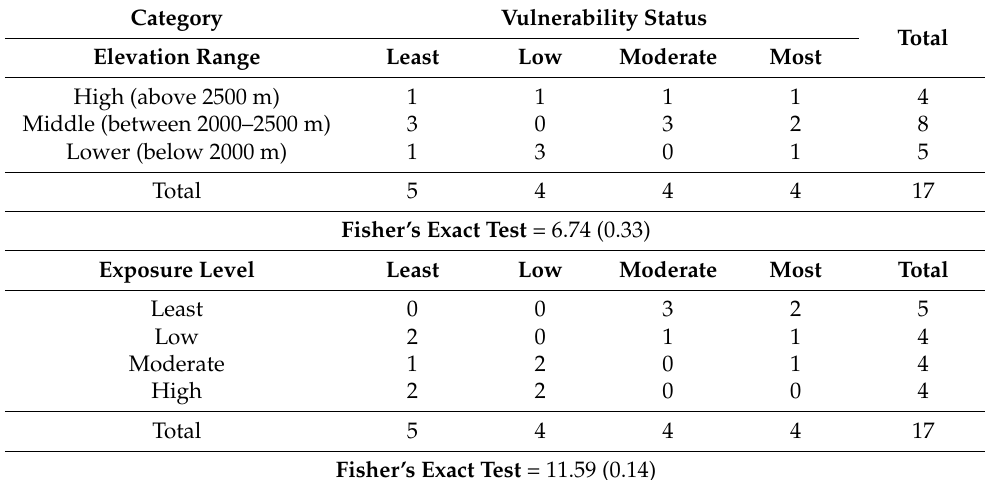
Table 3. Association between vulnerability status with elevation range and exposure level. Category Vulnerability